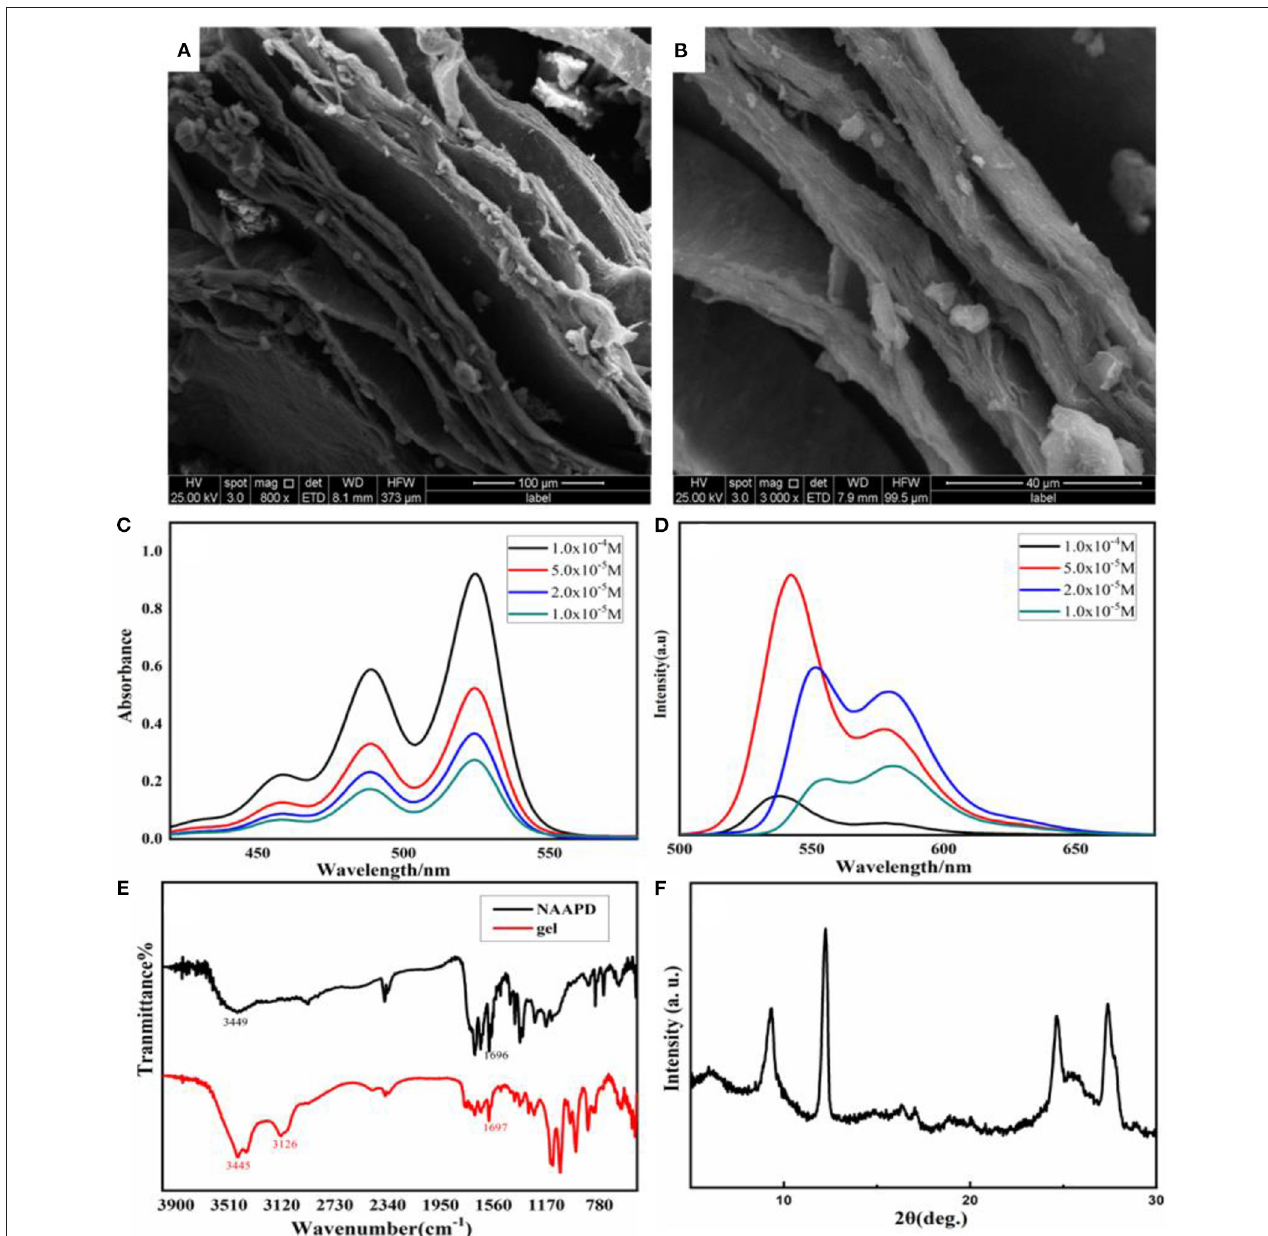
FIGURE 2 | Scanning electron microscopy (SEM) images of the NAAPD xerogel: (A) in larger scale and (B) in small scale. Spectra of NAAPD solutions in THF/H 2 O = 1:1 with different concentrations: (C) UV-vis spectra of the NAAPD loose gel at room temperature (path length = 2.0mm), (D) fluorescence spectra of the solution and the gel of the NAAPD system at room temperature, at λ ex = 486nm (path length = 5.0mm); (E) FT-IR spectra diluted with KBr for a xerogel (black) and powder (red); and (F) experimental powder XRD pattern of NAAPD